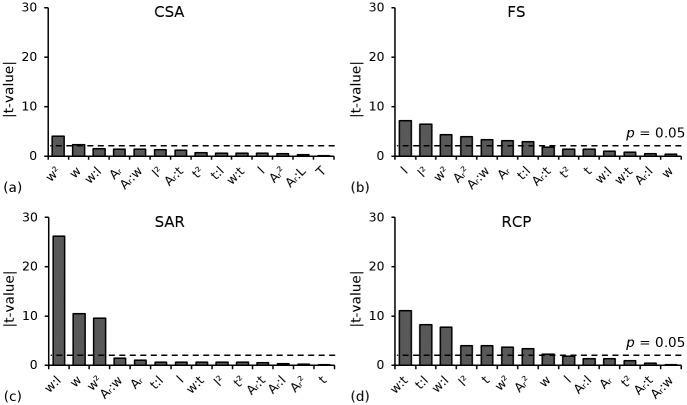
Comparison of absolute t-values (for coefficients) from multiple regression analyses highlighting significant (p < 0.05) main factors and two-way interactions for (a) CSA; (b) FS; (c) SAR and (d) RCP.